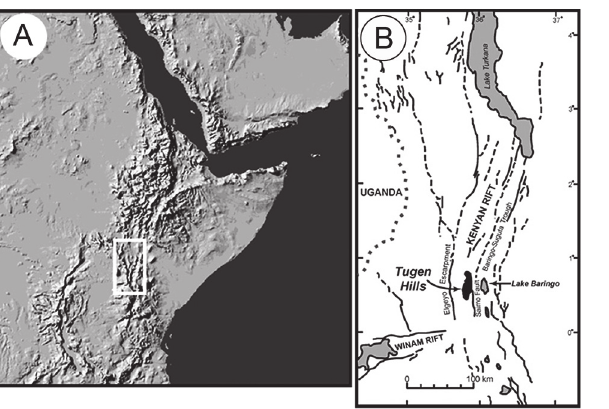
Fig 1. Geographic overview of the East African Rift System (EARS) and the study site (Reprinted from [37] with permission from Elsevier). A Map of East Africa with the location of the EARS; B Detail of the EARS with the location of the Tugen